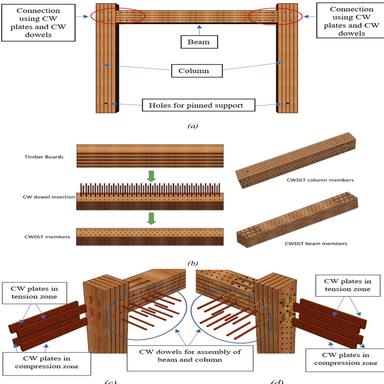
Frame configuration (a) beam-column arrangement and connection location, (b) design concept of CWDLT members, (c) localised connections using glued members and CW connectors, and (d) localised connections using CWDLT members.